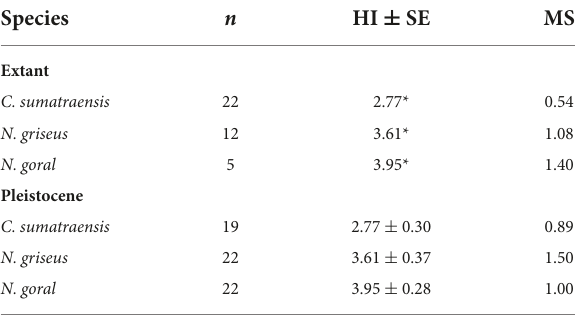
TABLE 3 Hypsodonty index (HI) for species and mesowear score (MS) of extant and Pleistocene